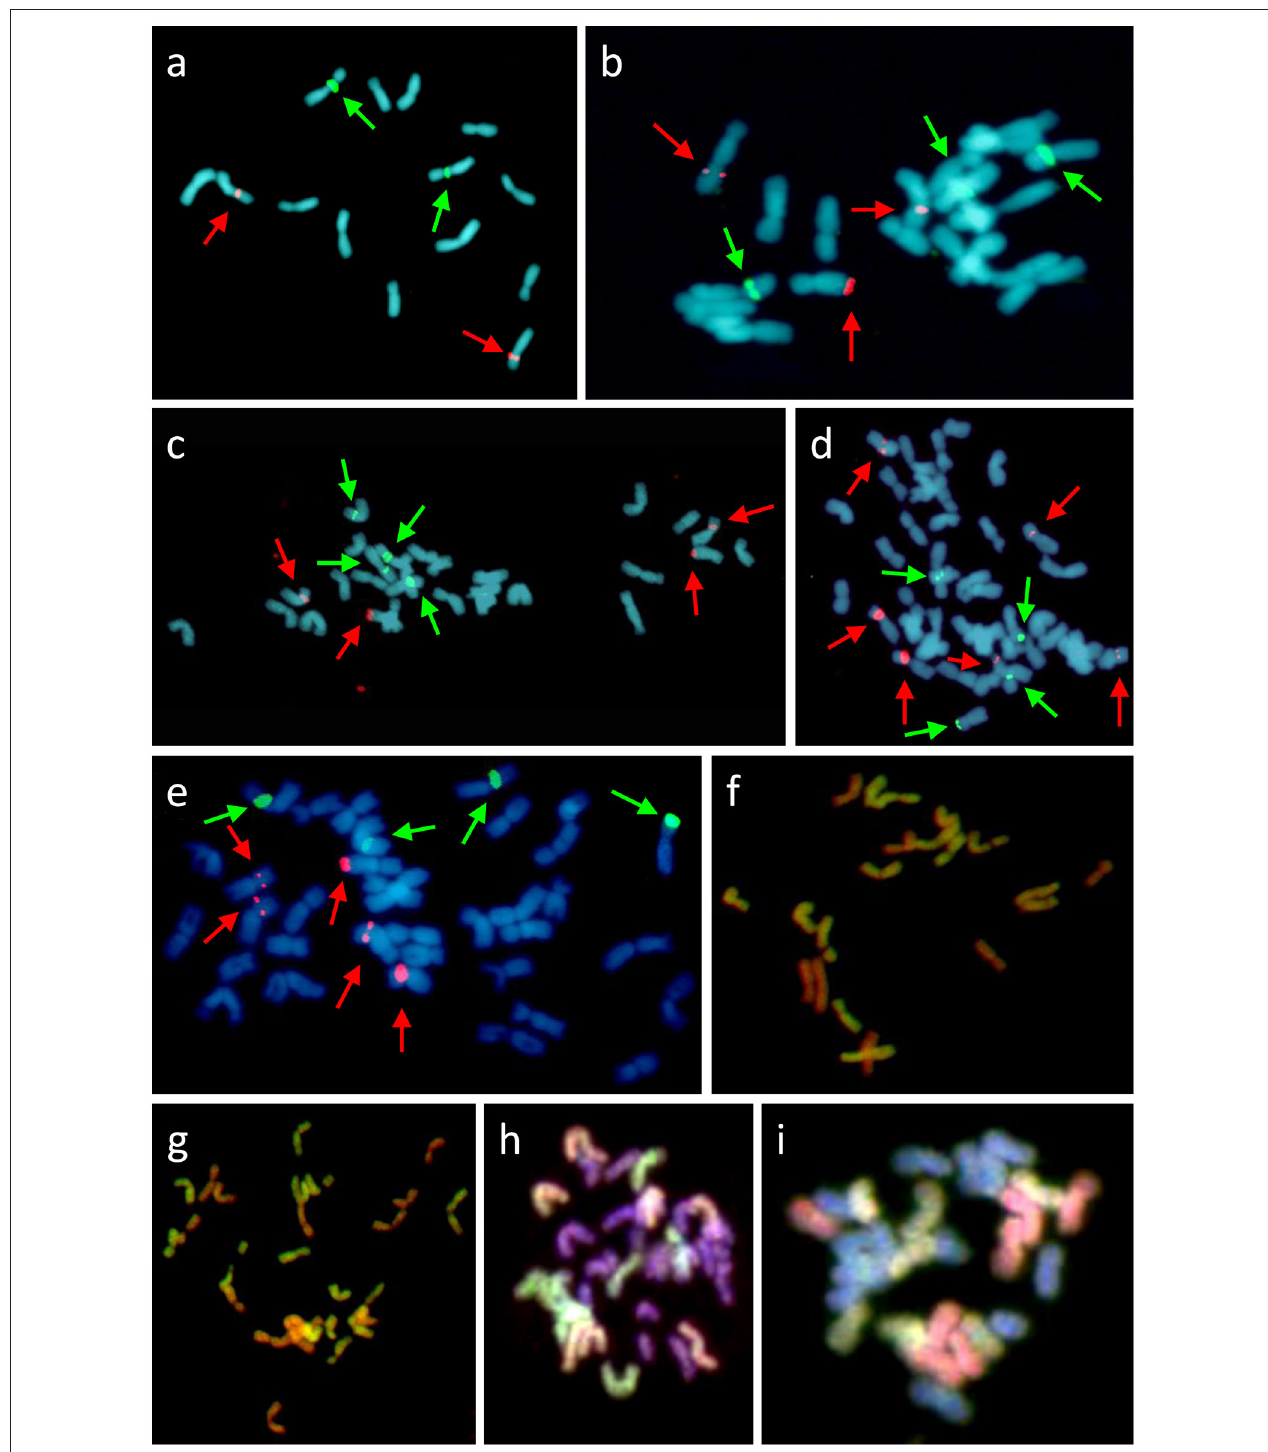
FIGURE 3 | Cytogenetic analysis of F. pratensis/F. apennina/F. arundinacea complex (A–G) and L. multiflorum × F. apennina hybrid (H,I). FISH with probes for 5S rDNA (red color, highlighted with red arrows) and 45S rDNA (green color, highlighted with green arrows) on metaphase spreads of diploid F. pratensis (A) , triploid hybrid (B) , tetraploid F. apennina (C) , pentaploid hybrid (D) , and hexaploid F. arundinacea (E) . GISH with probe made from labeled gDNA of F. pratensis and blocking DNA from sheared gDNA of F. glaucescens in triploid (F) and tetraploid (G) revealed hybrid origin of both cytotypes. Additional GISH analysis of tetraploid L. multiflorum × F. apennina hybrid with two probe combinations: (H) gDNA of F. pratensis (red color) and gDNA of F. apennina (green color) and (I) gDNA of F. pratensis (green color) and F. glaucescens (red color). Chromosomes were counterstained with DAPI (blue color).